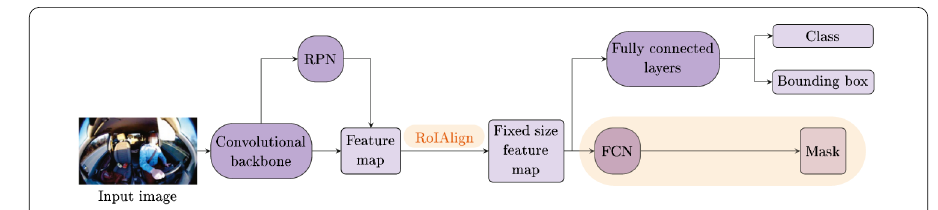
Figure 5 Architecture of the Mask R-CNN. The orange shaded parts represent the extensions of the Faster R-CNN by which the Mask R-CNN is derived (according to [37, 38])